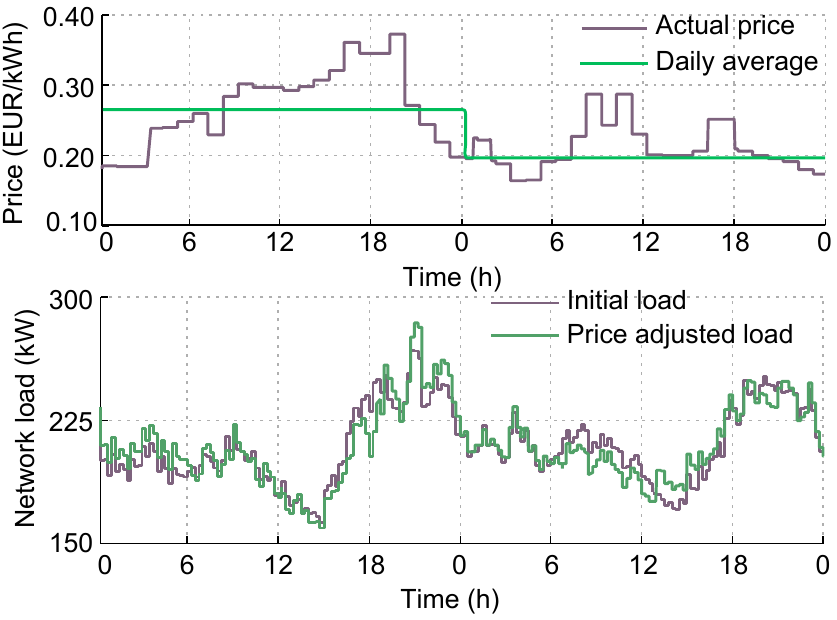
Figure 6. E ff ects of dynamic price on day-ahead scheduled Figure 6. Effects of dynamic price on day-ahead scheduled load.